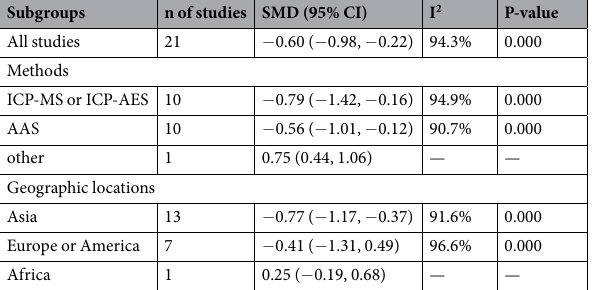
— — Table 3. Meta-analysis of studies on serum together with plasma. SMD with the corresponding 95% CI and p value, the I 2 statistic for overall and subgroup analyses. SMD, Standardized mean difference; CI, confidence interval.